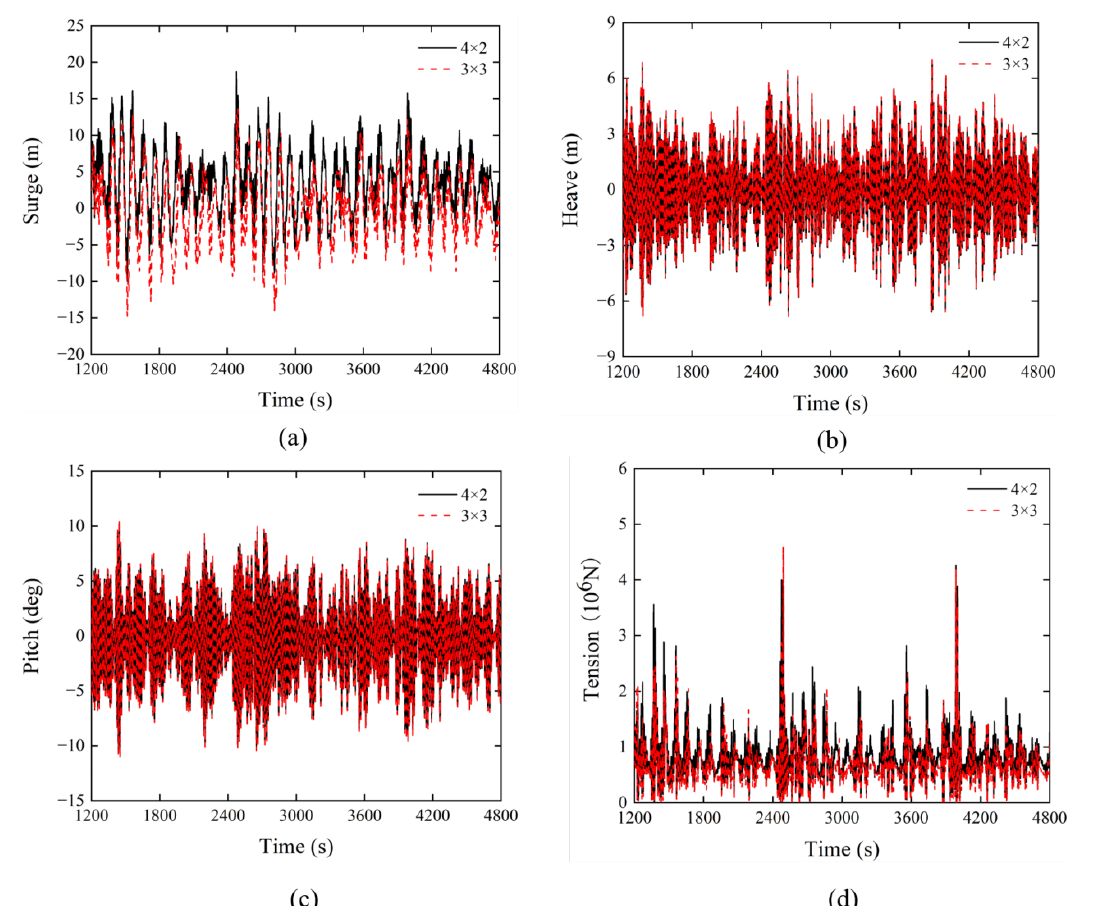
Figure 11. Comparison of ( a ) surge, ( b ) heave, ( c ) pitch, and ( d ) top tension of mooring line T5 in the 4 × 2 system and mooring line T6 in the 3 × 3 system for LC1.